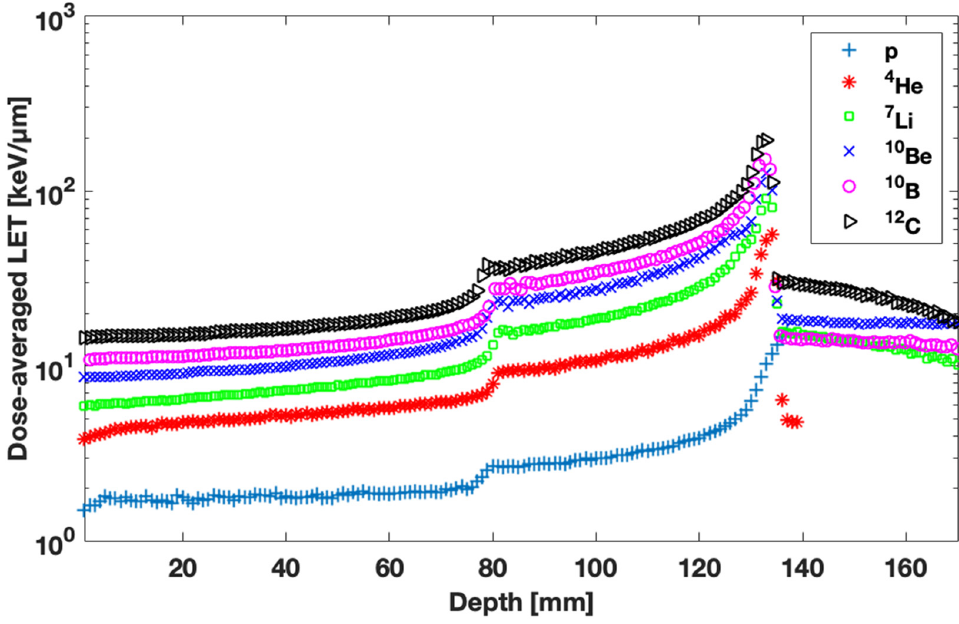
Figure 3. Dose-averaged LET as a function of depth for all ion beams considered in this study. By combining FLUKA results with calculations by the MCDS code and assuming a well ‐ oxygenated target, (total) 𝑅𝐵𝐸 (cid:3005)(cid:3020)(cid:3003) values as a function of depth are presented in Fig ‐ ure 4. For all ion beams considered, 𝑅𝐵𝐸 (cid:3005)(cid:3020)(cid:3003) greatly increases at the end of the SOBP area, indicatively exceeding 2.5 for the 12 C ions.